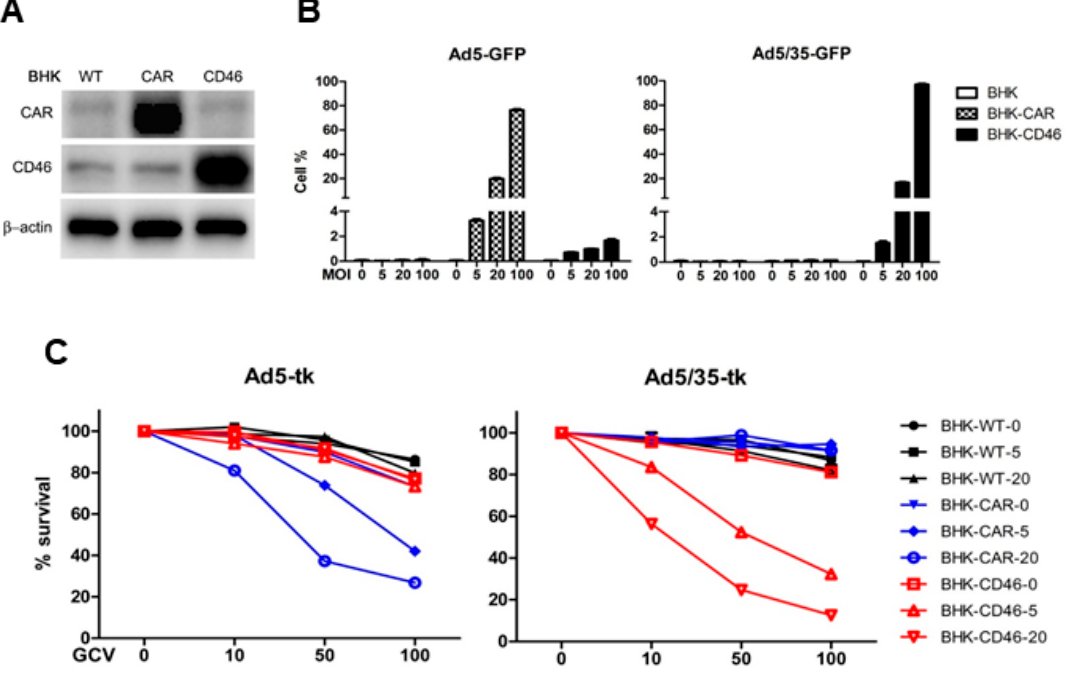
Figure 3. Gene transduction efficacy of adenovirus (Ad)5/35 is enhanced in CD46 ‐ expressing cells. ( A ) Western blot analysis of CAR and CD46 expression in parental rodent baby hamster kidney (BHK) cells or BHK ‐ CAR and BHK ‐ CD46 cells, which ectopically express the Ad receptors CAR and CD46, respectively. ( B ) Flow cytometry analysis of Ad ‐ mediated green fluorescent protein (GFP) expression